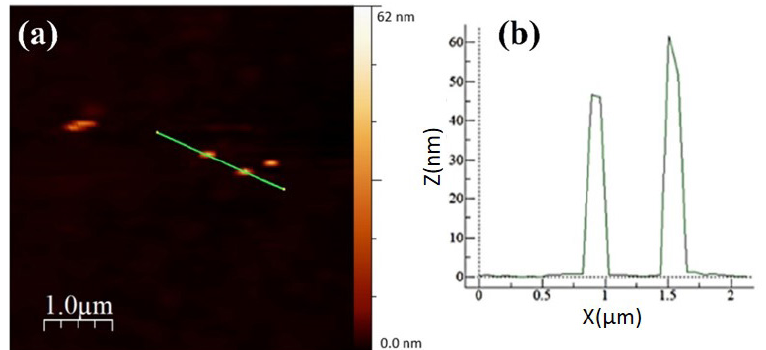
nanoparticles. B) Size distribution of NPs (c) 602 kX magnification of Fe@SiO 2 2